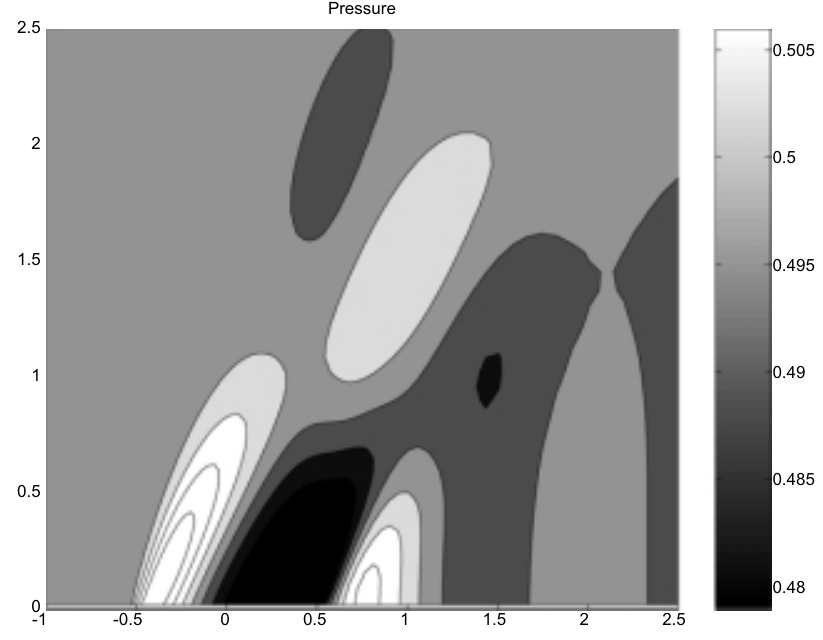
Fig. 24. Pressures after 20 second simulation, full model with δ 1 = 0 . 01